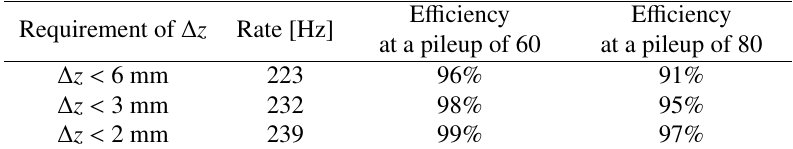
Figure 3. Illustration of the impact parameters of a track in the transverse plan (left) and RZ- plane (right). The transverse impact parameter d 0 is defined as the distance of closest approach to the beam line (z-axis). The longitudinal impact parameter z 0 is defined as the value of z of the point on the track that determines d 0 . A more detailed description of the impact parameters can be found in Ref. [4]. Table 1. The rate and e ffi ciency of the isolated muon trigger with a p T threshold of 26 GeV (mu26_ivarmedium) for three ∆ z